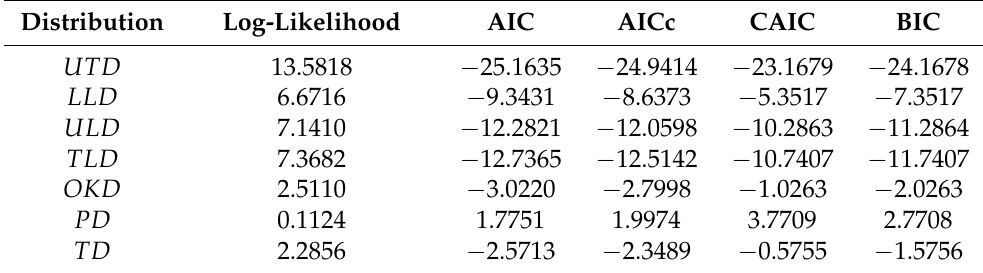
Table 8. Log-likelihood, AIC, AICc, CAIC, and BIC values for flood level data. Distribution